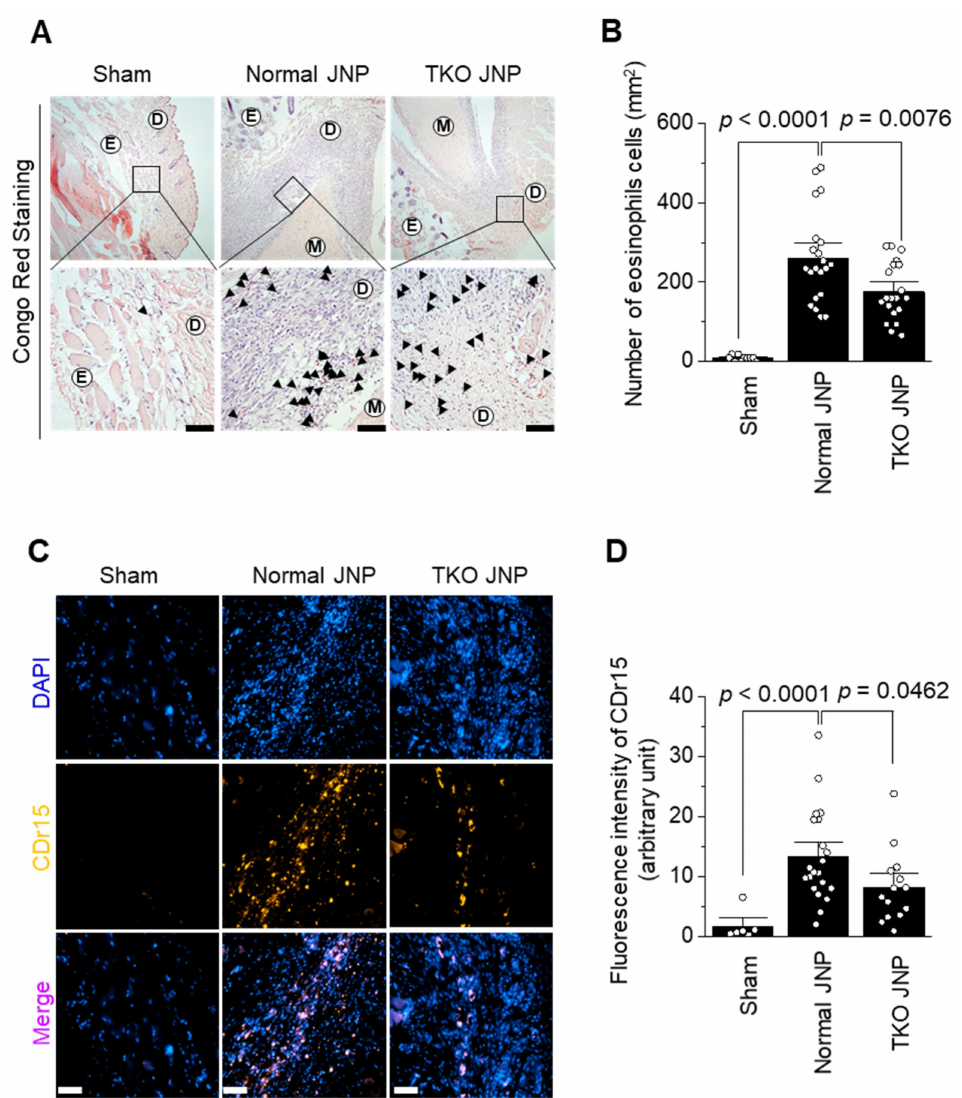
Figure 4. Immunohistochemical analysis of eosinophil and extracellular trap (NET) infiltration in the sham, normal, and TKO JNP groups. The distribution of eosinophils and NET was analyzed by the Congo red ( A ) and CDr15 ( C ) staining. The quantification of eosinophils ( B ) and NET ( D ) is represented. In each field, eosinophil count for the sham ( n = 10), normal ( n = 21), and TKO JNP ( n = 20) groups; and NET count for the sham ( n = 6), normal ( n = 21), and TKO JNP ( n = 14) groups were determined. A two-tailed independent t -test was used for statistical analysis. E: epidermis; D: dermis; M: meniscus. Magnification of A (upper panel: 100X, lower panel: 400X) and C (200X). Scale bars: 50 µ m. DAPI (blue for nucleus), CDr15 (Yellow for neutrophil extracellular trap), Merge (DAPI +